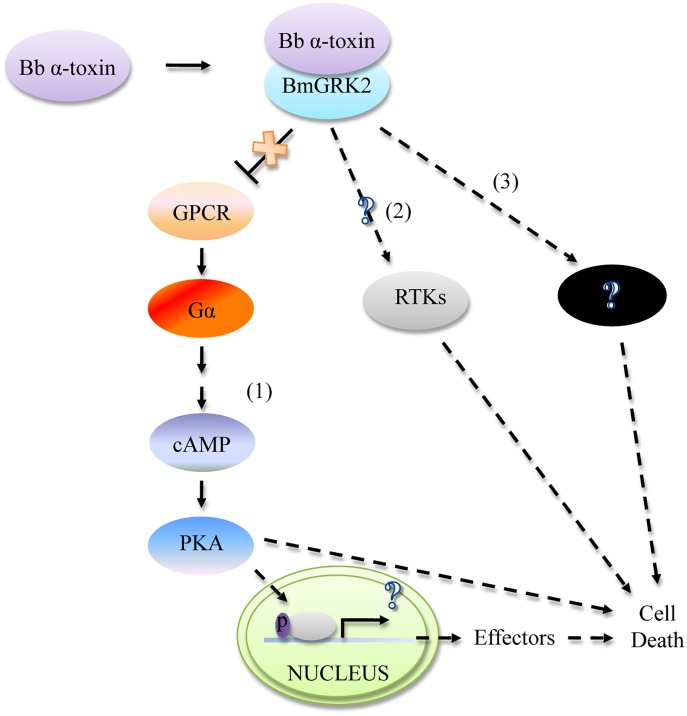
Schematic model for Bb α-toxin action.
Bb α-toxin bound to BmGRK2, a key GPCR regulatory kinase, affecting the modulation of GPCRs signaling pathway, leaded to a continuous up-regulation of downstream activity, which stimulates Gαs, promotes production of cAMP, and activates PKA. In turn, PKA activation alters effectors that disturb homeostasis and many fundamental biological process that destroy midgut cells, inducing larvae death (pathway 1). Alternatively, Bb α-toxin bound to BmGRK2 may also alter the signals downstream of receptor tyrosine kinases (RTKs) that are involved in cell cycle phases, but whether these signaling pathways participate in the Bb α-toxin pathogenic mechanism is unknown (pathway 2). Activation of some other signaling pathway is not through pathway 1 or pathway 2 but through other unknown receptors (pathway 3) in Bb α-toxin pathogenic mechanism. All of these pathways work together, leading to cell death.